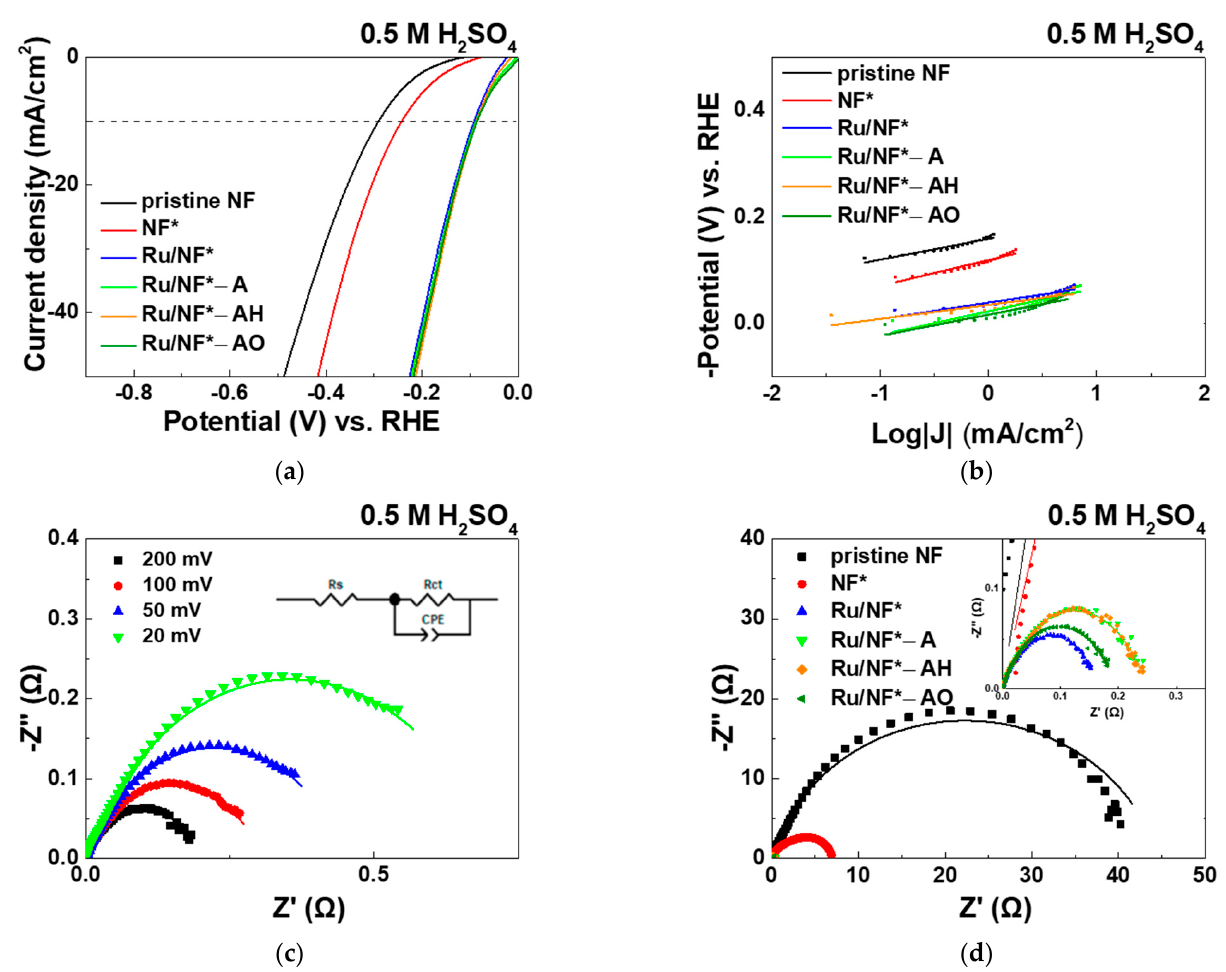
Figure 7. In 0.5 M H 2 SO 4 aqueous solution: ( a ) LSV polarization curves of pristine NF, NF*, Ru/NF*, Ru/NF*-A, Ru/NF*-AH, and Ru/NF*-AO catalysts toward HER. ( b ) Corresponding Tafel plots of HER. ( c ) Nyquist plots of the Ru/NF*-AO catalyst at four different applied overpotentials versus RHE. ( d ) Nyquist plots of pristine NF, NF*, Ru/NF*, Ru/NF*-A, Ru/NF*-AH, and Ru/NF*-AO catalysts at an overpotential of 200 mV versus RHE. Table 4. The corresponding parameters of the electrocatalyst in 0.5 M H 2 SO 4 aqueous solution cal- culated from Figure 7.